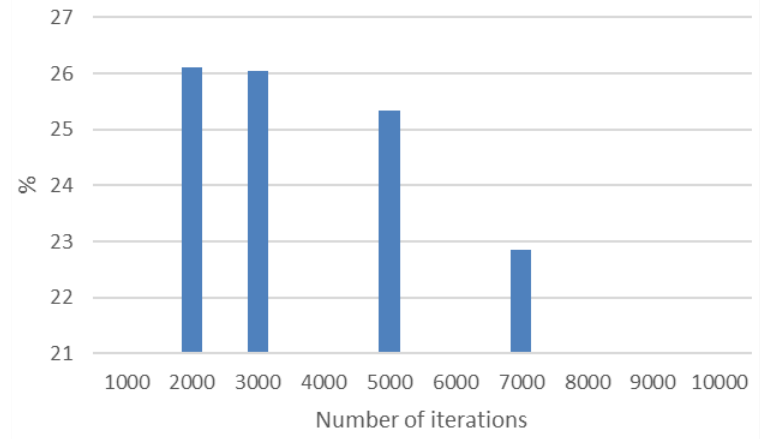
Figure 6. Dependence of the MAPE on the number of iterations of the proposed evolutional method, with reference to the absolute error.